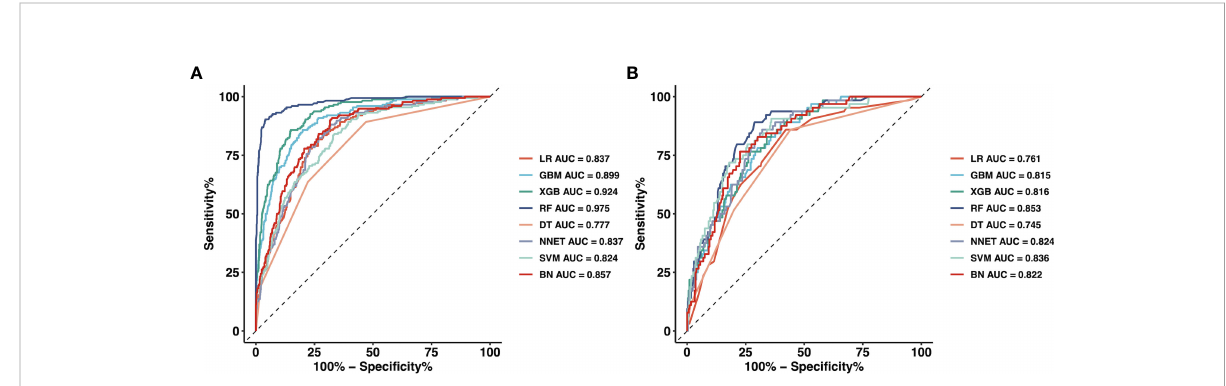
FIGURE 1 The mixed ROC curves of the eight machine learning models for prediction of LLNM. (A) The mixed ROC curves in the training cohort; (B) The mixed ROC curves in the validation cohort. ROC receiver operating characteristic; LLNM Lateral lymph node metastasis; LR Logistic Regression; GBM Gradient Boosting Machine; XGB Extreme Gradient Boosting; RF Random Forest; DT Decision Tree; NNET Neural Network, SVM Support Vector Machine; BN Bayesian